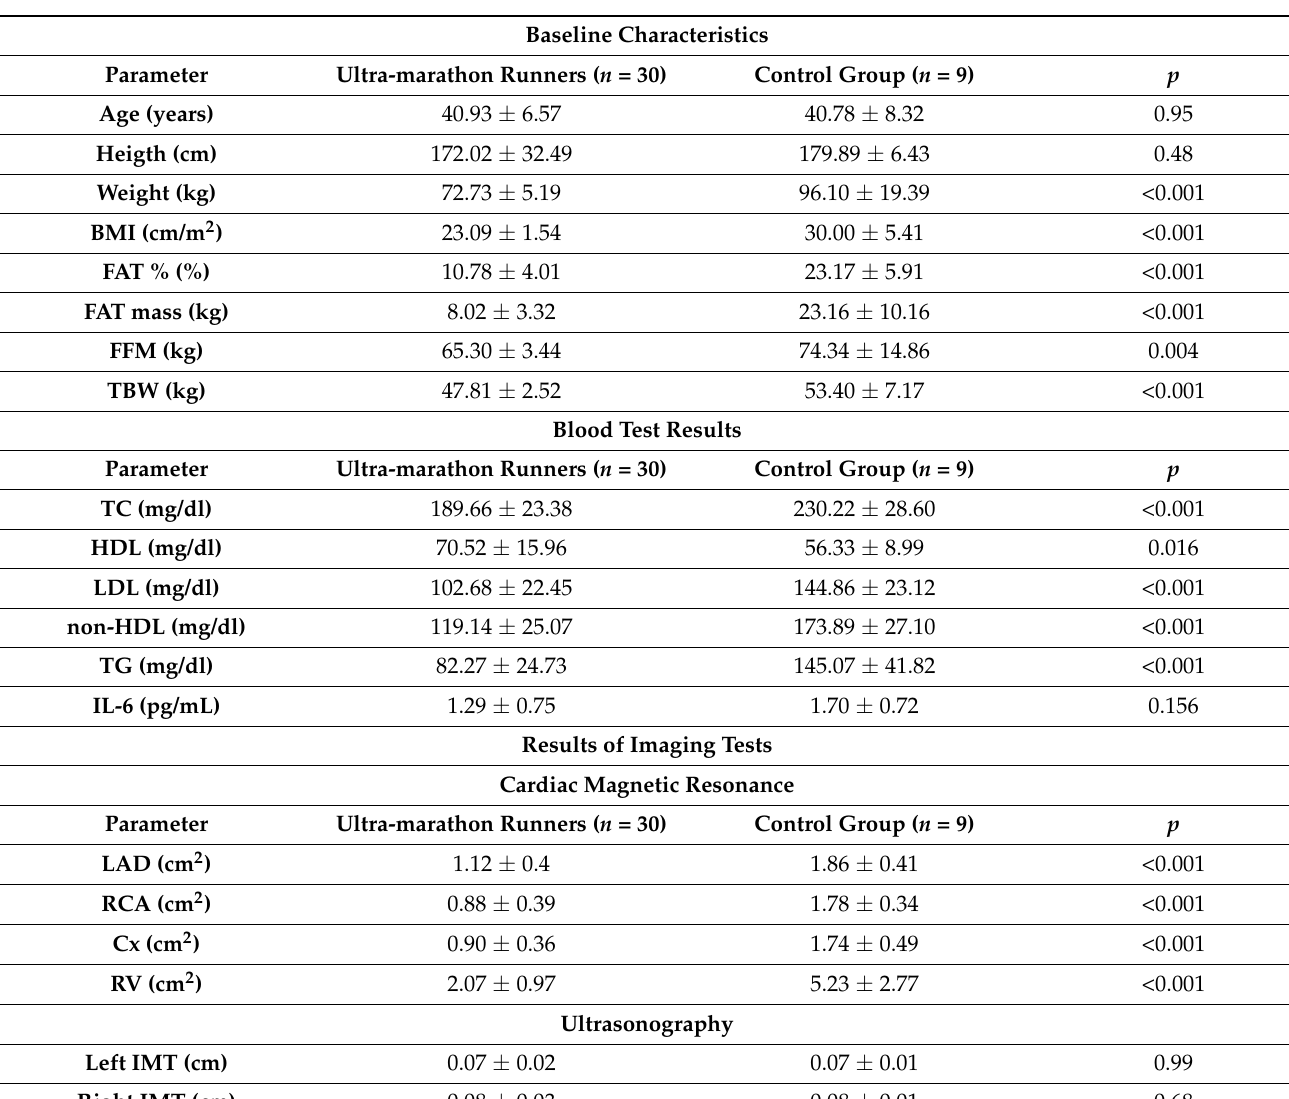
Table 2. Participants’ baseline characteristics and